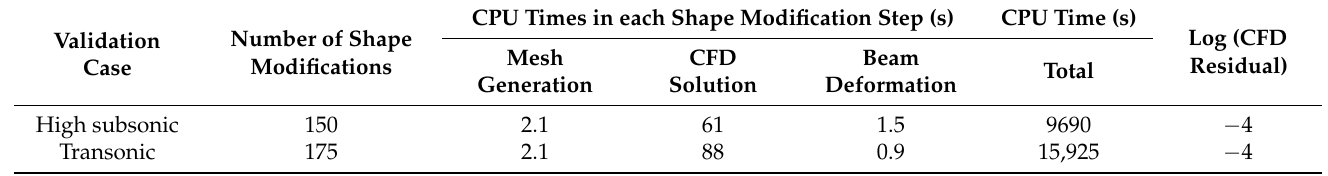
Table 2. CPU times, number of shape modifications and the convergence residuals for the validation cases.